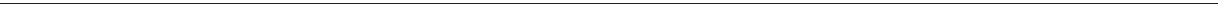
Fig. 6 Constitutively active FoxM1 ameliorates mitotic fi tness and aging markers in elderly cells. a Movie frames of elderly dividing cells expressing H2B – GFP/ α -Tubulin – mCherry (upper panel) and H2B – GFP/ α -Tubulin – mCherry + FoxM1-dNdK (lower panel) (Supplementary Movies 5, 6). Time, min:s. Scale bar, 5 µ m. b Heatmap of genes within the “ mitosis ” GO term differentially expressed in mitotic elderly cells transduced with lentiviral empty vector or vector expressing FoxM1-dNdK (2logFC cutoff value < − 0.5 and > 0.5, p -value < 0.05, FDR < 5%, Supplementary Data 13). c Venn diagram illustrating the overlap between mitosis genes altered in 87 y, 10 y FoxM1 siRNA-depleted, and 87 y FoxM1-dNdK-expressing fi broblasts (Supplementary Data 14). d Mitotic duration (NEB to anaphase onset) in elderly fi broblasts infected with control and FoxM1-dNdK lentiviruses. e Aneusomy index in interphase FISH. f Chromosome mis-segregation rate in CytoD-FISH. g , h Percentage of cells staining positive for the senescence markers β -galactosidase g and 53BPl/p2l h . i Heatmap of SASP and senescence ( CDKN1A , CDKN2A , LMNB1 ) genes differentially expressed in HDF 87 y and 87 y FoxM1-dNdK (Supplementary Data 15); 2logFCs in red indicate genes behaving differently from expected 36, 37 . j Heatmap of senescence core signature genes ’ expression in 87 y and 87 y FoxM1-dNdK (Supplementary Data 16); 2logFCs in red indicate genes behaving differently from expected 37 . In all heatmaps, p -value < 0.05; genes represented in columns and technical replicates represented in rows; Z -score column color intensities representing higher (red) to lower (blue) expression. Values are mean ± SD of three independent experiments. Sample size ( n ) is indicated in each graph. * p ≤ 0.05, ** p ≤ 0.01, *** p ≤ 0.001, and **** p ≤ 0.0001 by two-tailed Mann – Whitney ( d ) and χ 2 ( e – h ) statistical